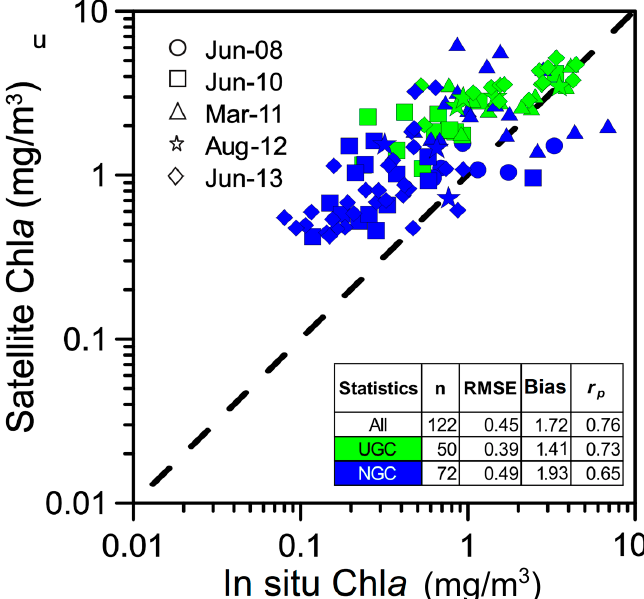
Figure 6 . Relationship between in situ chlorophyll data (Chl a ) and satellite chlorophyll data for the June 2008, June 2010, March 2011, August 2012, and June 2013 cruises, plotted on a logarithmic scale. The dashed line is the one-to-one line. RMSE is computed on log10-transformed data, and bias on original data.